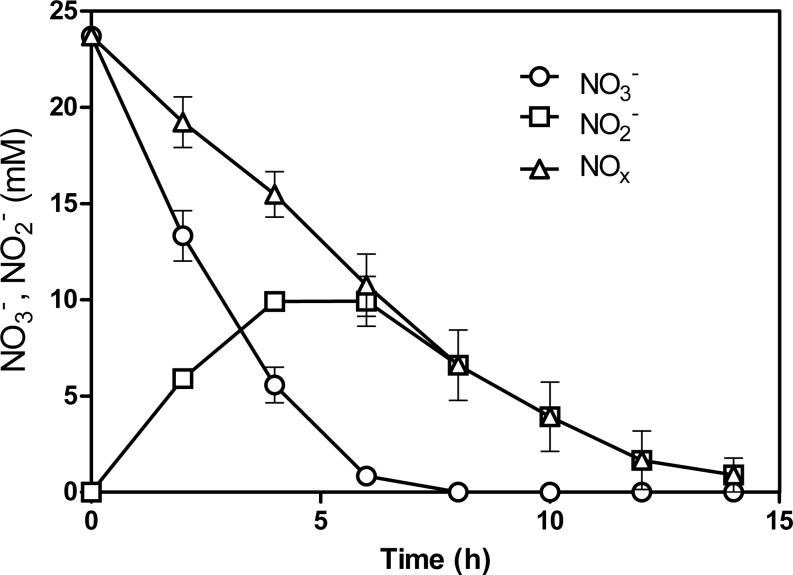
NO\documentclass[12pt]{minimal}
\usepackage{amsmath}
\usepackage{wasysym}
\usepackage{amsfonts}
\usepackage{amssymb}
\usepackage{amsbsy}
\usepackage{upgreek}
\usepackage{mathrsfs}
\setlength{\oddsidemargin}{-69pt}
\begin{document}
}{}${}_{3}^{-}$\end{document}3− and NO\documentclass[12pt]{minimal}
\usepackage{amsmath}
\usepackage{wasysym}
\usepackage{amsfonts}
\usepackage{amssymb}
\usepackage{amsbsy}
\usepackage{upgreek}
\usepackage{mathrsfs}
\setlength{\oddsidemargin}{-69pt}
\begin{document}
}{}${}_{2}^{-}$\end{document}2− reduction by the acclimated biofilm.The biofilm was batch-cultured under anoxic conditions. After the 5th transfer, the NO\documentclass[12pt]{minimal}
\usepackage{amsmath}
\usepackage{wasysym}
\usepackage{amsfonts}
\usepackage{amssymb}
\usepackage{amsbsy}
\usepackage{upgreek}
\usepackage{mathrsfs}
\setlength{\oddsidemargin}{-69pt}
\begin{document}
}{}${}_{3}^{-}$\end{document}3− and NO\documentclass[12pt]{minimal}
\usepackage{amsmath}
\usepackage{wasysym}
\usepackage{amsfonts}
\usepackage{amssymb}
\usepackage{amsbsy}
\usepackage{upgreek}
\usepackage{mathrsfs}
\setlength{\oddsidemargin}{-69pt}
\begin{document}
}{}${}_{2}^{-}$\end{document}2− concentrations were measured over different time intervals. NOx: combined measurements of NO\documentclass[12pt]{minimal}
\usepackage{amsmath}
\usepackage{wasysym}
\usepackage{amsfonts}
\usepackage{amssymb}
\usepackage{amsbsy}
\usepackage{upgreek}
\usepackage{mathrsfs}
\setlength{\oddsidemargin}{-69pt}
\begin{document}
}{}${}_{3}^{-}$\end{document}3− and NO\documentclass[12pt]{minimal}
\usepackage{amsmath}
\usepackage{wasysym}
\usepackage{amsfonts}
\usepackage{amssymb}
\usepackage{amsbsy}
\usepackage{upgreek}
\usepackage{mathrsfs}
\setlength{\oddsidemargin}{-69pt}
\begin{document}
}{}${}_{2}^{-}$\end{document}2−. Each point is the average with standard deviation of triplicate cultures.